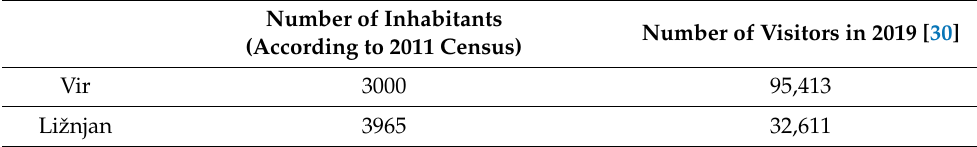
Table 1. Comparison of number of inhabitants and number of visitors of Vir and